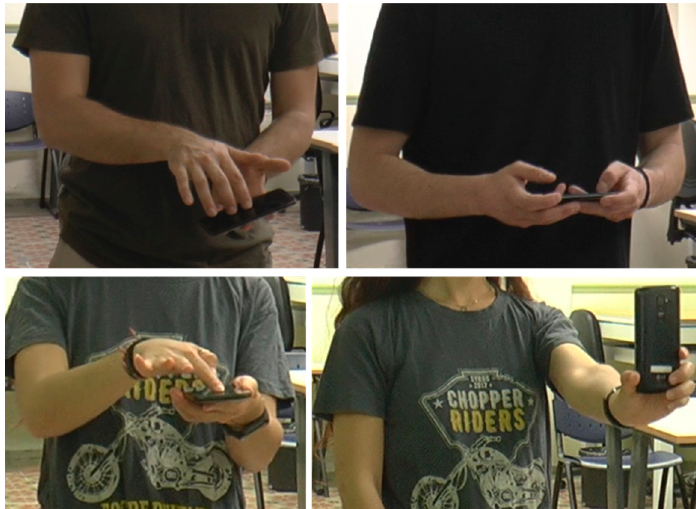
Figure 9. Four pictures of the elicited gestures. A user proposed two finger rotation for turning to the left or right (upper left); a typical gamer configuration with two virtual joysticks, one for each thumb (upper right); a user switched between the horizontal (lower left) and vertical (lower right) angle for walking and looking around, respectively.